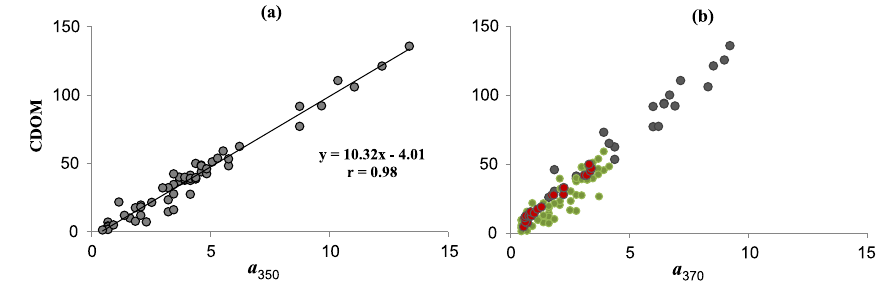
Figure 8. Correlation between CDOM (QSU) and the absorption coefficient at 350nm ( a 350 , m − 1 ) in ESAS surface water (a) and the relationship between CDOM (QSU) and absorption coefficient at 370nm ( a 370 , m − 1 ) in the water column (b) in September 2004. Grey is our data in the Laptev Sea ( N = 23); green is our data in the East Siberian Sea ( N = 69), and red is data from Belzile et al. (2006) ( N =